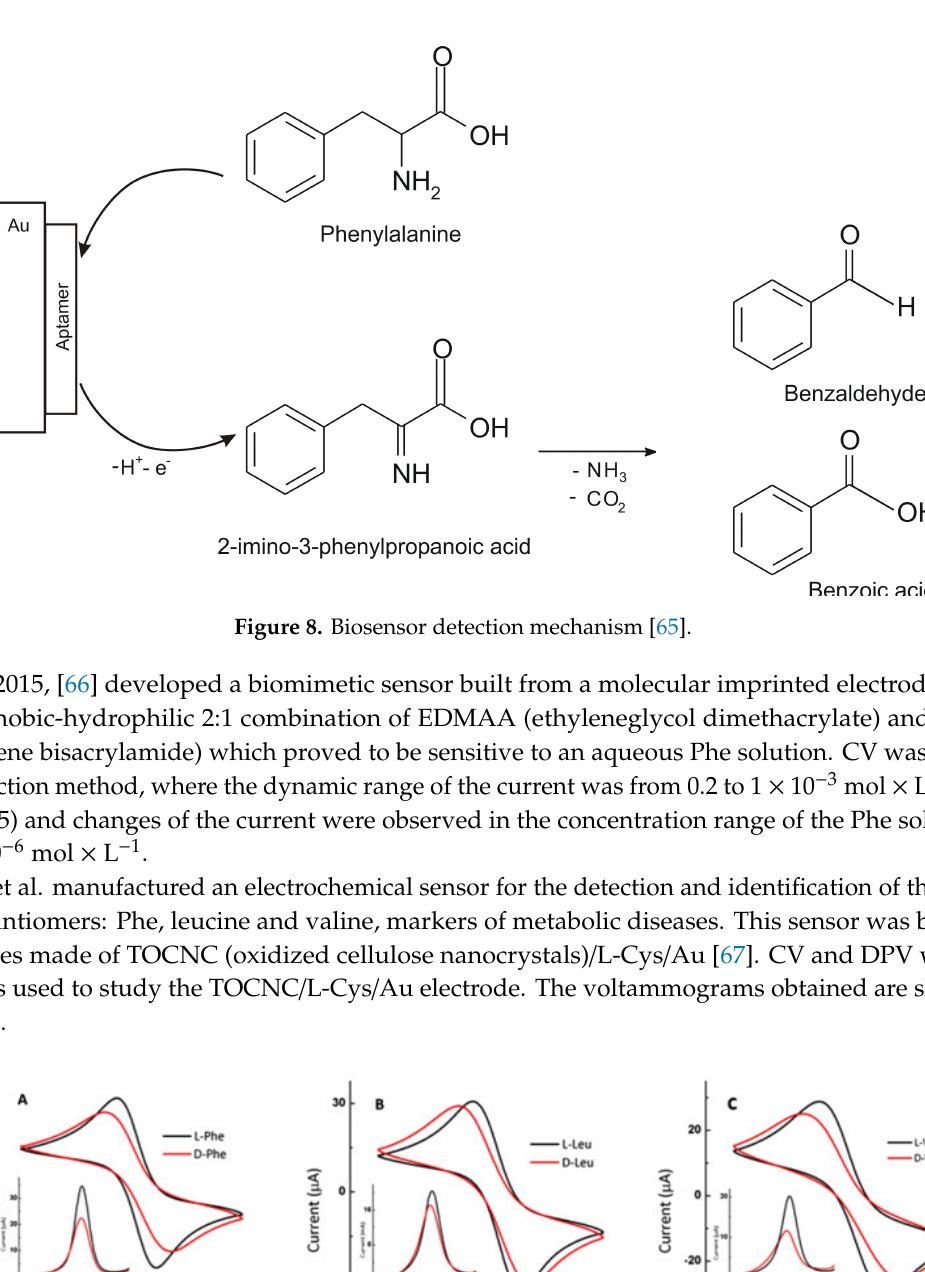
Figure 8. Biosensor detection mechanism. [65] .